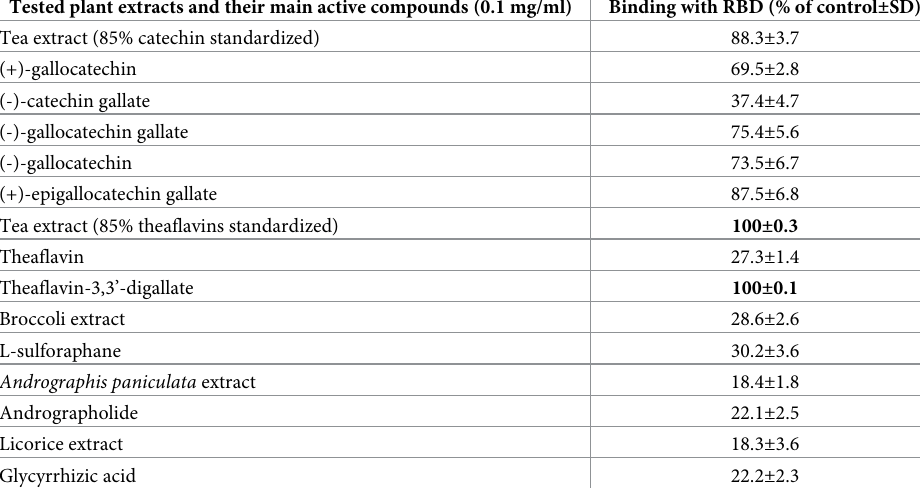
Table 2. Binding of selected plant extracts and their major components with RBD of SARS-CoV-2. Tested plant extracts and their main active compounds (0.1 mg/ml)